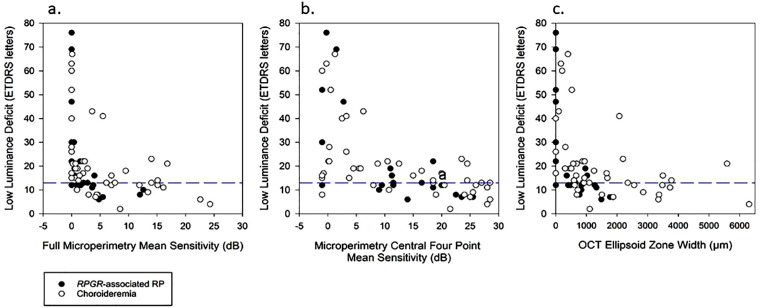
The relationships between LLD and structure-function variables such as OCT and microperimetry. (a) Microperimetry mean sensitivity and LLD showing a significant negative Spearman rank correlation for both choroideremia (ρ = −0.59, P < 0.001) and RPGR-associated RP (ρ = −0.83, P < 0.001). (b) Low luminance deficit and microperimetry central 4-point mean sensitivity correlation analysis, showing a significant negative Spearman rank correlation again with both choroideremia (ρ = −0.61, P < 0.001) and RPGR-associated RP (ρ = −0.68, P < 0.001). (c) OCT ellipsoid zone width and LLD correlation, with both data sets showed a significant Spearman rank correlation, choroideremia (ρ = −0.59, P < 0.001) and RPGR-associated RP (ρ = −0.76, P < 0.001). The horizontal blue dashed lines highlight 13 LLD, which is the upper normal limit for controls.